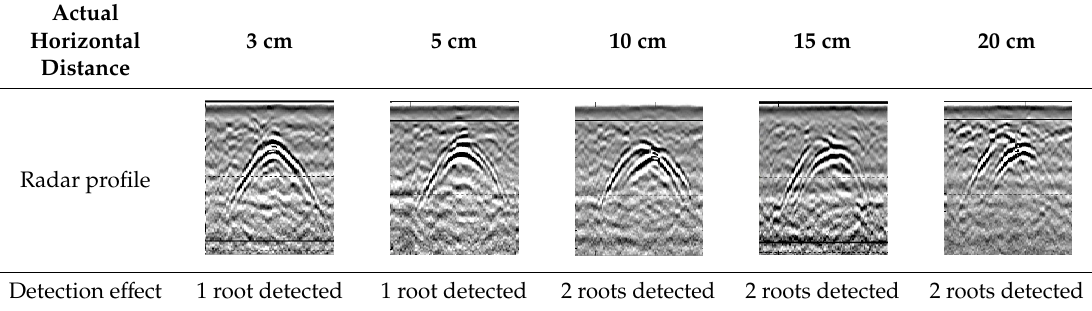
Table 3. Radar profiles of two roots buried at different horizontal distances from one another.